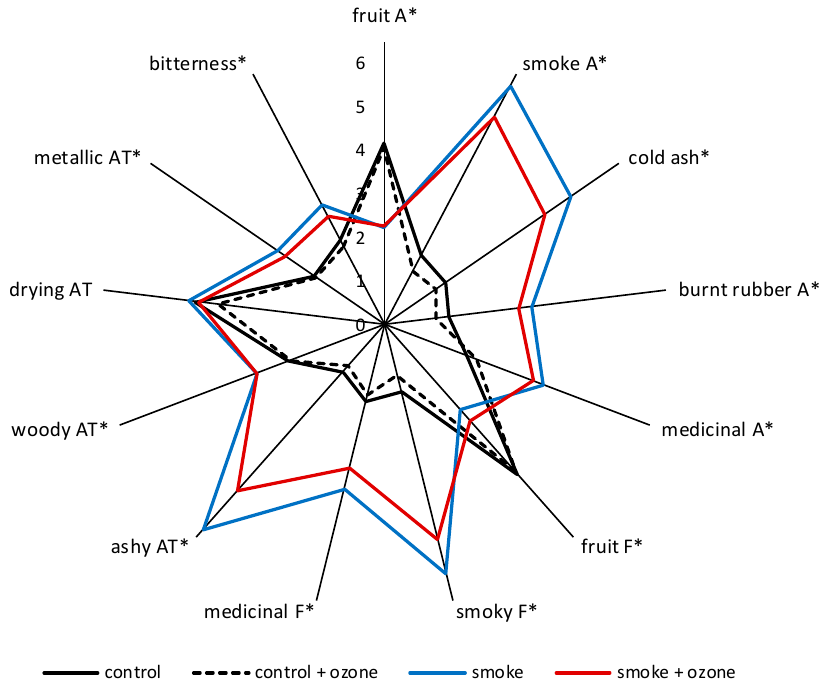
Figure 1. Sensory profiles of Cabernet Sauvignon wines made with control or smoke-exposed grapes, with or without post-harvest ozone treatment (1 ppm for 24 h). A = aroma; F = flavor; AT = aftertaste. Data are mean ratings from three wine replicates, each evaluated by 15 judges; * indicates statistical significance ( p = 0.05, two-way ANOVA).